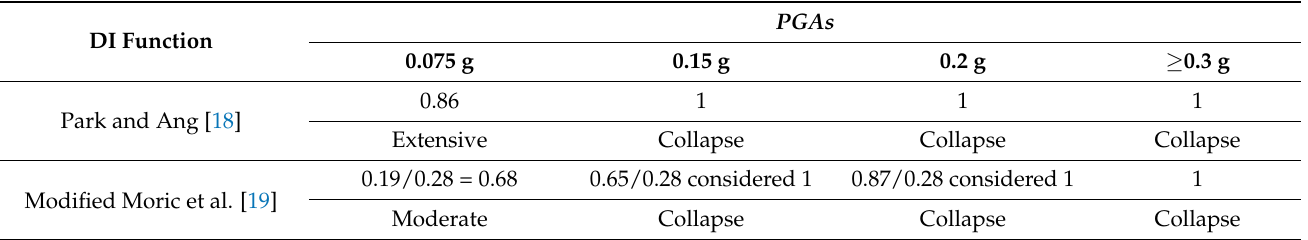
Table 4. DI values versus different PGAs at T = 0.25